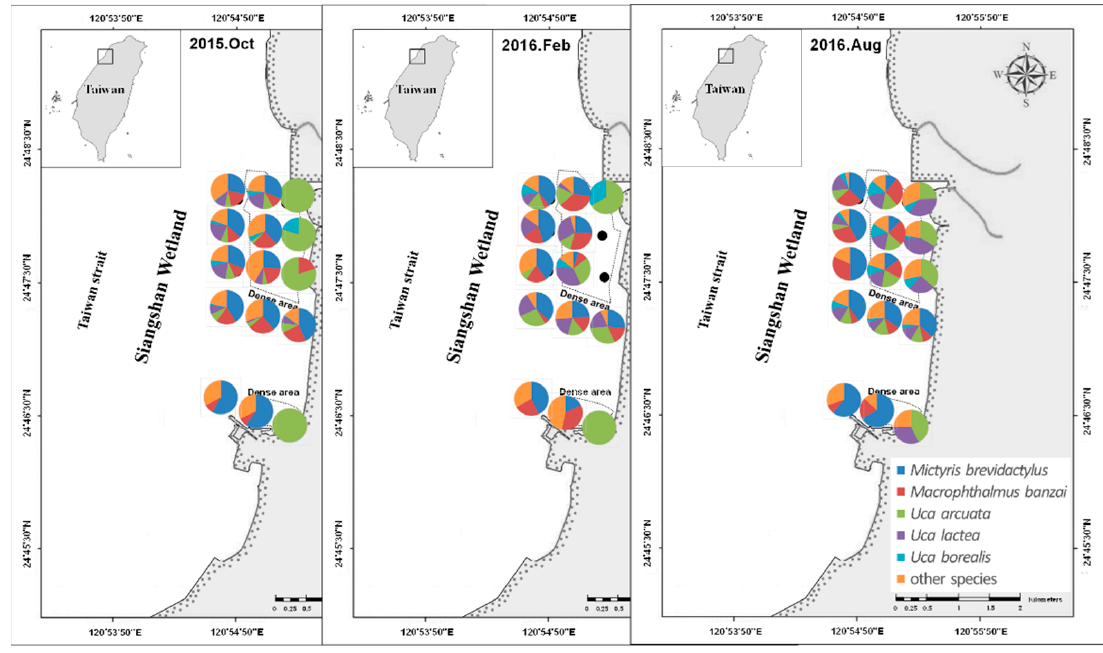
Figure 2. Spatiotemporal variations of target species with its quantity.